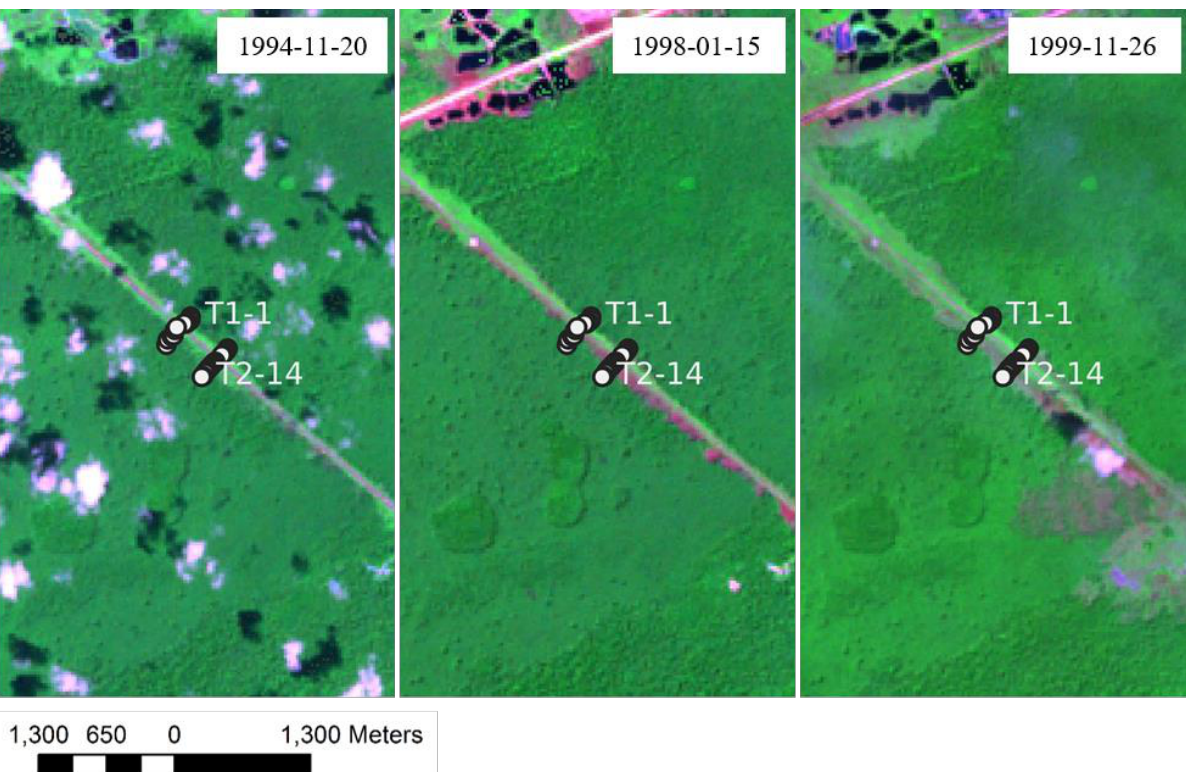
Figure A4. Sample Landsat images used for scoring (red band: short-wave infrared; green: near infrared; blue: red). Forest appears in shades of dark green, recently burned areas are pink, purple or red, and clear areas (low vegetation) appear light